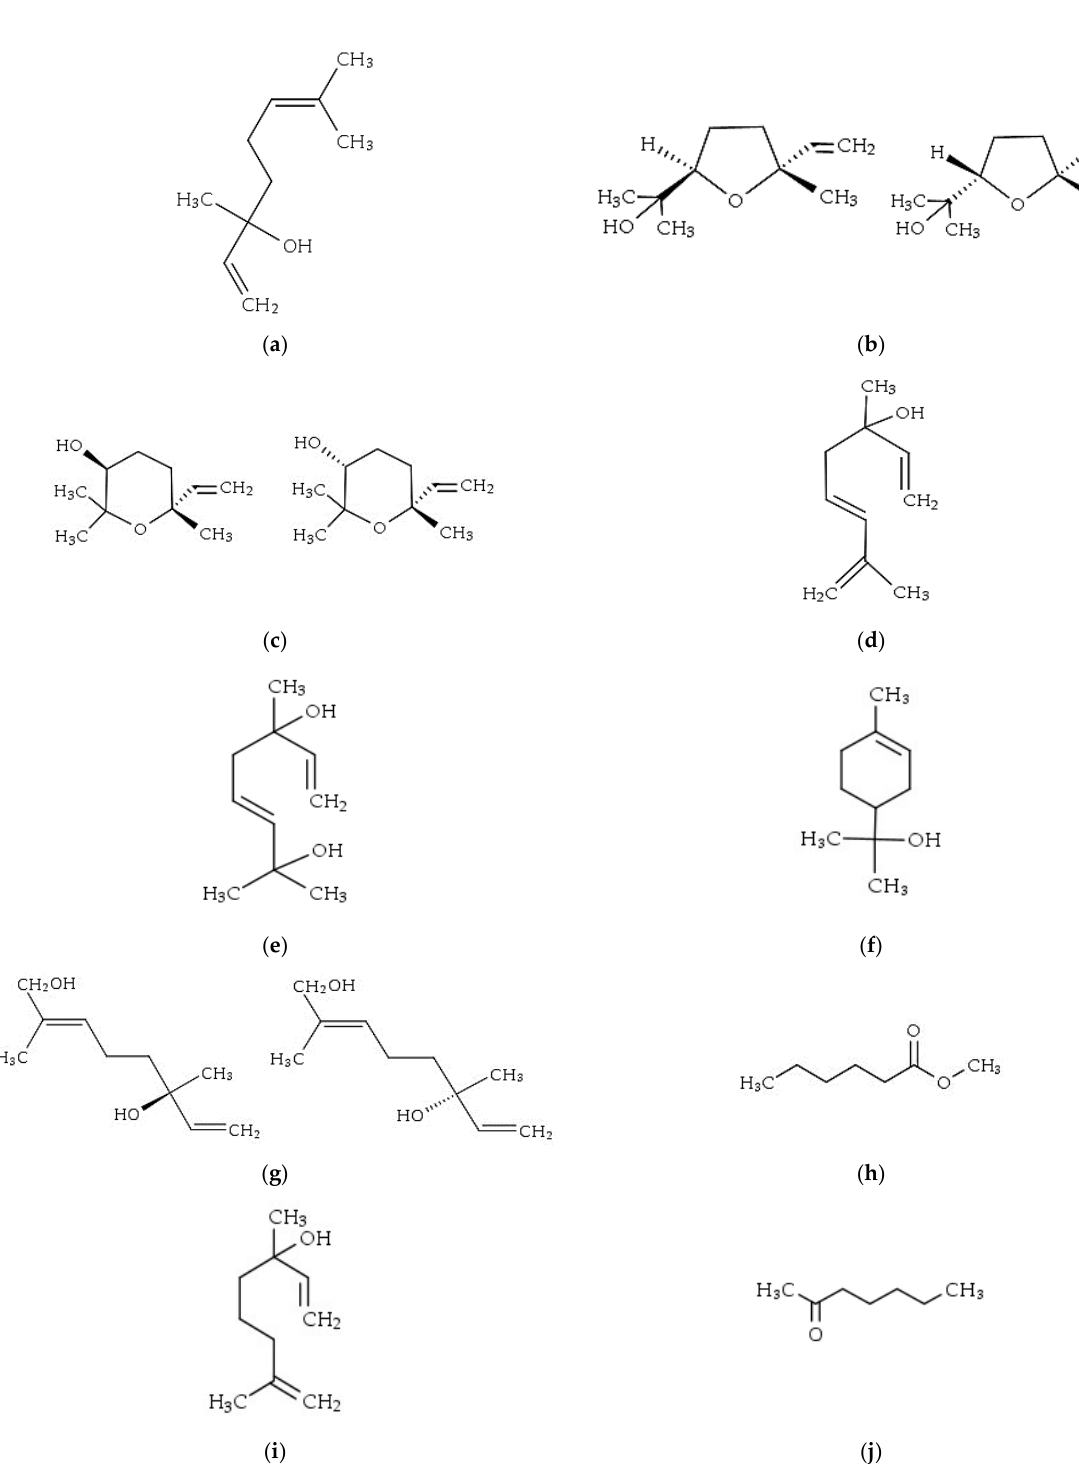
Figure 2. Volatile compounds of the aroma of bacuri. ( a ) Linalool. ( b ) (E) and (Z) Linalool furanoxides. ( c ) (E) and (Z) Linalool Pyranoxides. ( d ) Hotrienol. ( e ) 2,6-dimethyl-octa-3,7-dien-2,6-diol. ( f ) α -terpineol. ( g ) (E) and (Z)-2,6-dimethyl-octa-2,7-dien-1,6-diol. ( h ) Methyl hexanoate. ( i ) 2,6-dimethyl-octa-1,7-dien-3,6-diol. ( j ) 2-heptanone. According to Boulanger et al. [46], the identification of the presence of fatty acid esters, ethyl hexanoate, methyl octadecanoate, ethyl octadecanoate, and dimethyl ketones with an odd number of carbons, even in small amounts, is an essential indicator of the